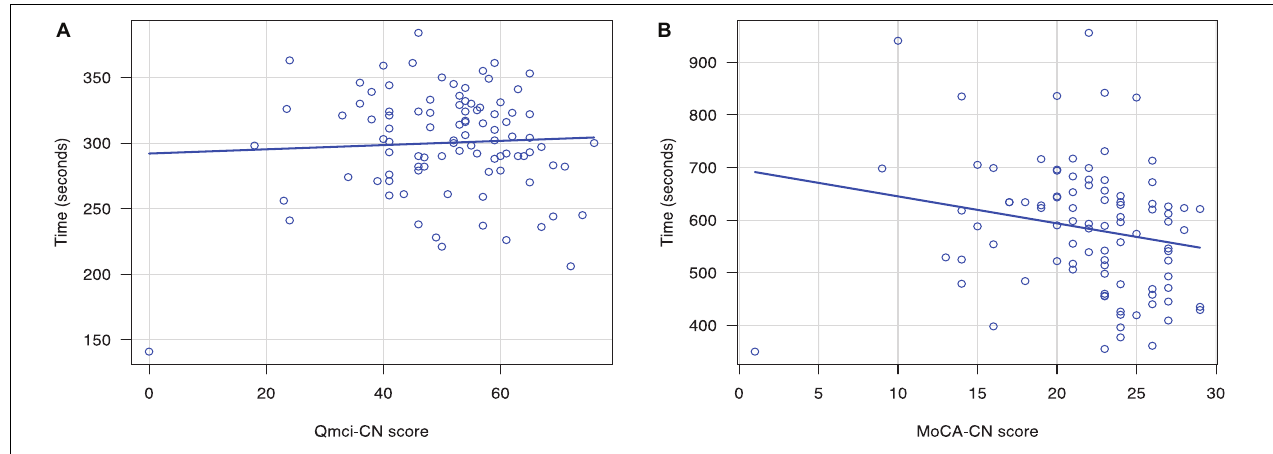
FIGURE 1 | Scatterplots showing the relationship between administration time and scores on the (A) Chinese versions of the Quick Mild Cognitive Impairment (Q mci -CN) screen and (B) Montreal Cognitive Assessment (MoCA-CN).